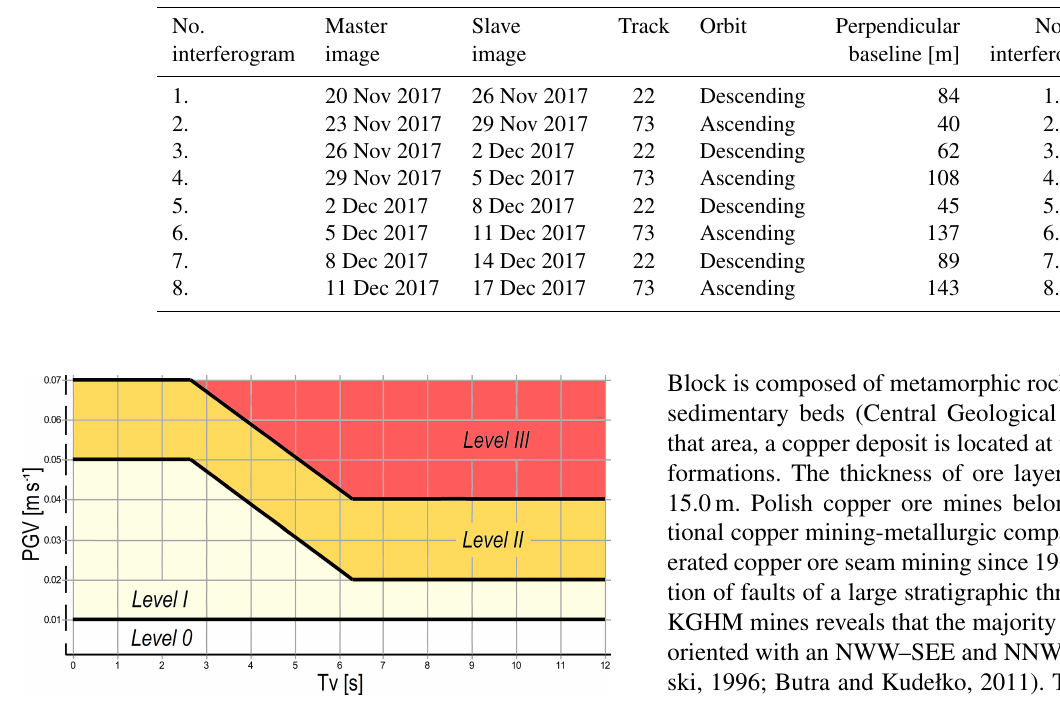
Figure 1. GSI-2004 seismic intensity scale. Degrees of seismic in- tensity (Level 0-III) are shown as a function of the earth vibration speed (PGV) and the duration of the main vibration phase (TV) (af- ter Wody´nski and Lasocki,